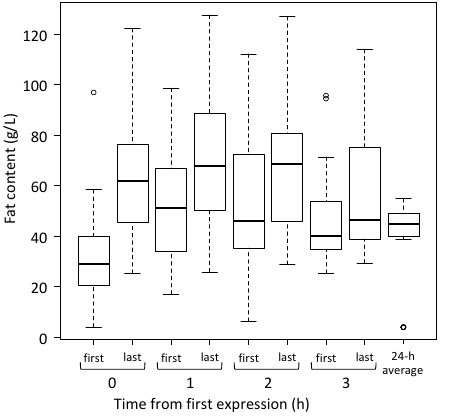
Figure 3. The fat content of first and last milk collected at each expression and the average fat content of milk samples collected during the 24-h milk profile data (24-h average). n = 29 breasts.